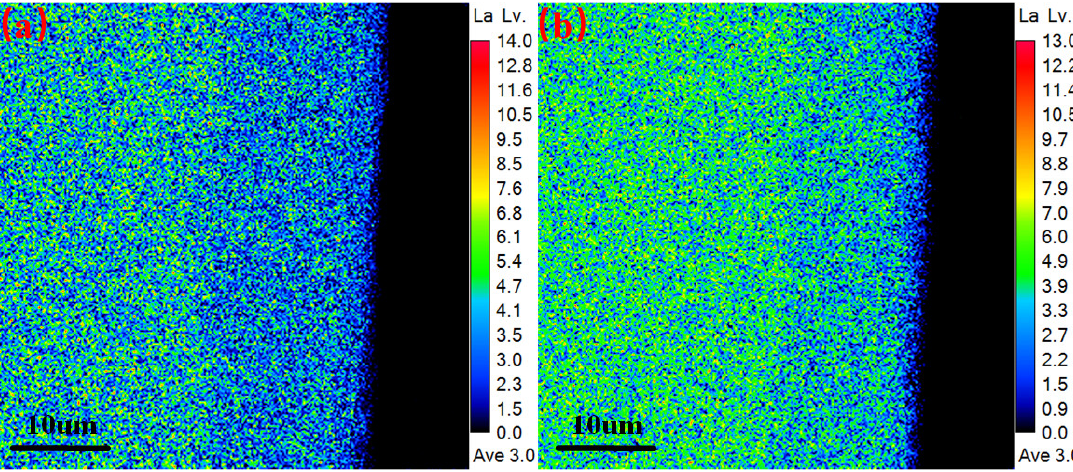
Figure 7. EPMA analysis of La element in vanadiumizing layer: ( a ) 0% La 2 O 3 and ( b ) 1% La 2 O 3.